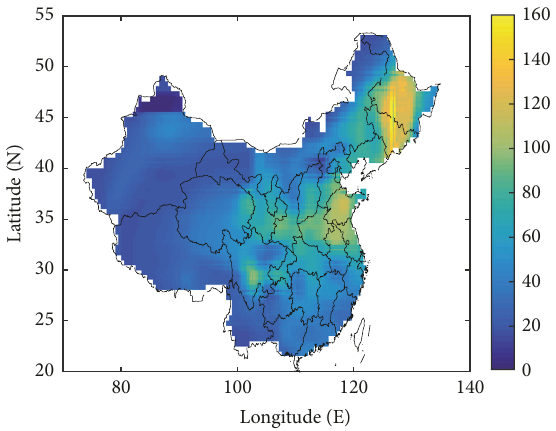
Figure 7: The mean field of PM 2.5 concentrations ( 𝜇 g/m 3